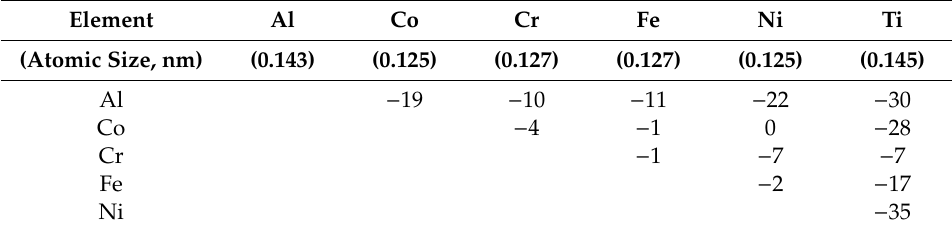
Table 3. The chemical mixing enthalpies of element pairs and atomic size [19,30]. The EBSD inverse pole figure (IPF) image of a region of 1180 µ m by 1056 µ m taken in the